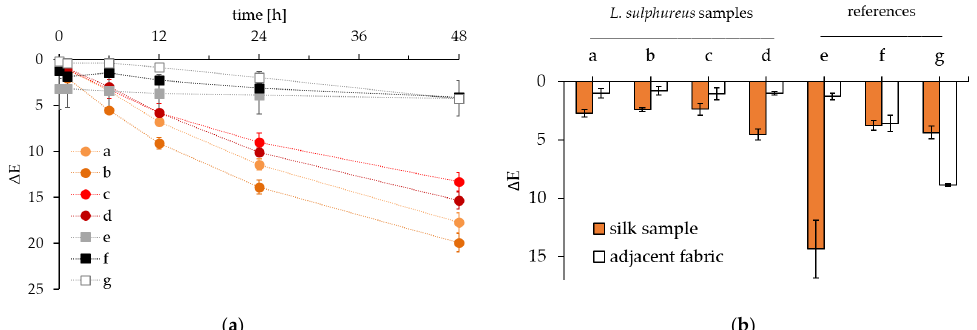
Figure 5. Comparison of the ( a ) light and ( b ) washing stability of silk samples dyed with L. sulphureus (a, b, c, d) and conventional textile dyes (e, f) against industrially dyed silk (g).